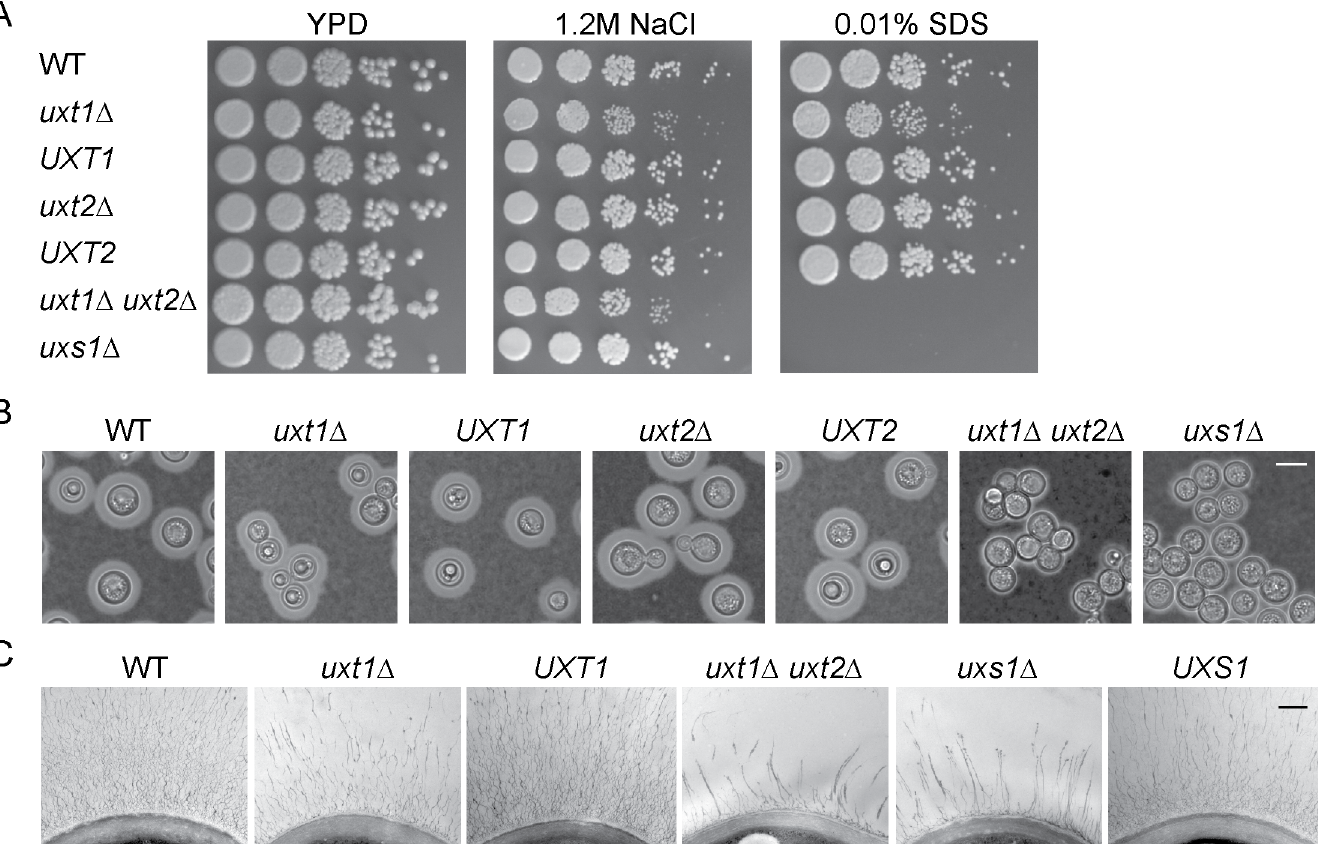
Fig 5. uxt1 Δ and uxt1 Δ uxt2 Δ mutants exhibit growth and capsule defects. (A) 5-fold serial dilutionsof the indicatedstrains, grown on the indicated media at 37˚C and photographed after three days. uxs1 Δ is includedas a control. (B and C) The indicatedstrains were placed in capsule-inducing conditions(see Materialsand Methods)for 24 h, and then visualizedby light microscopy after negative stainingwith India Ink (B, scale bar = 5 μ m) or by electron microscopy(C, scale bar = 0.5 μ m). AdditionalEM images are provided in S5D Fig.